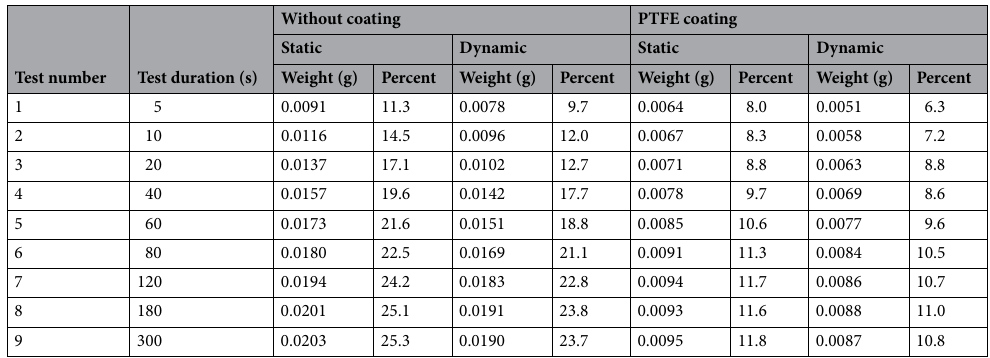
Table 5. Asphaltene deposition rate for uncoated and PTFE coated electrodes in static and dynamic states. Deposition value (electric field strength 2 kV/cm, 4% toluene concentration, 2000 ppm asphaltene concentration).